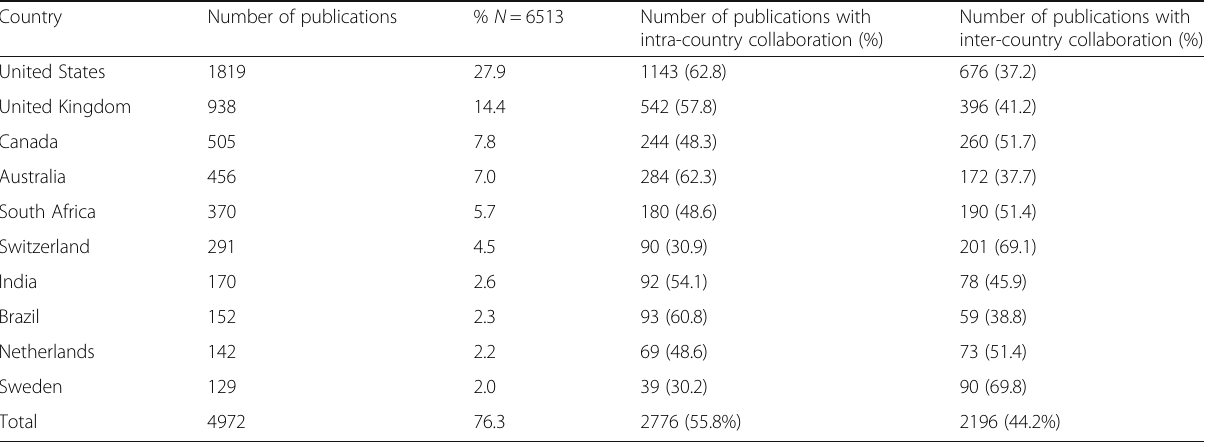
Table 2 Top 10 active countries in publishing documents on HHR Country